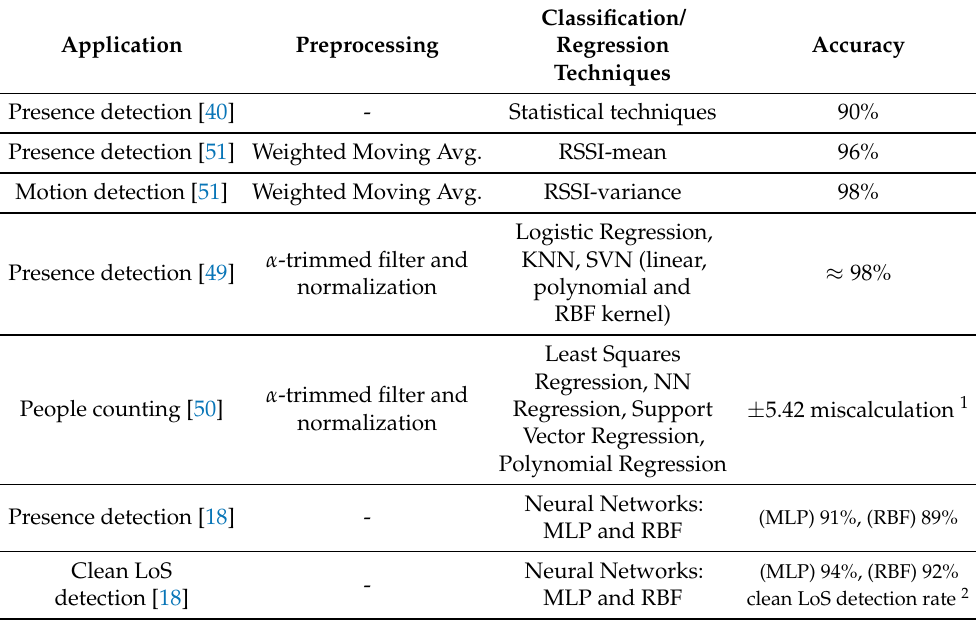
Table 2. Performance comparison of the considered